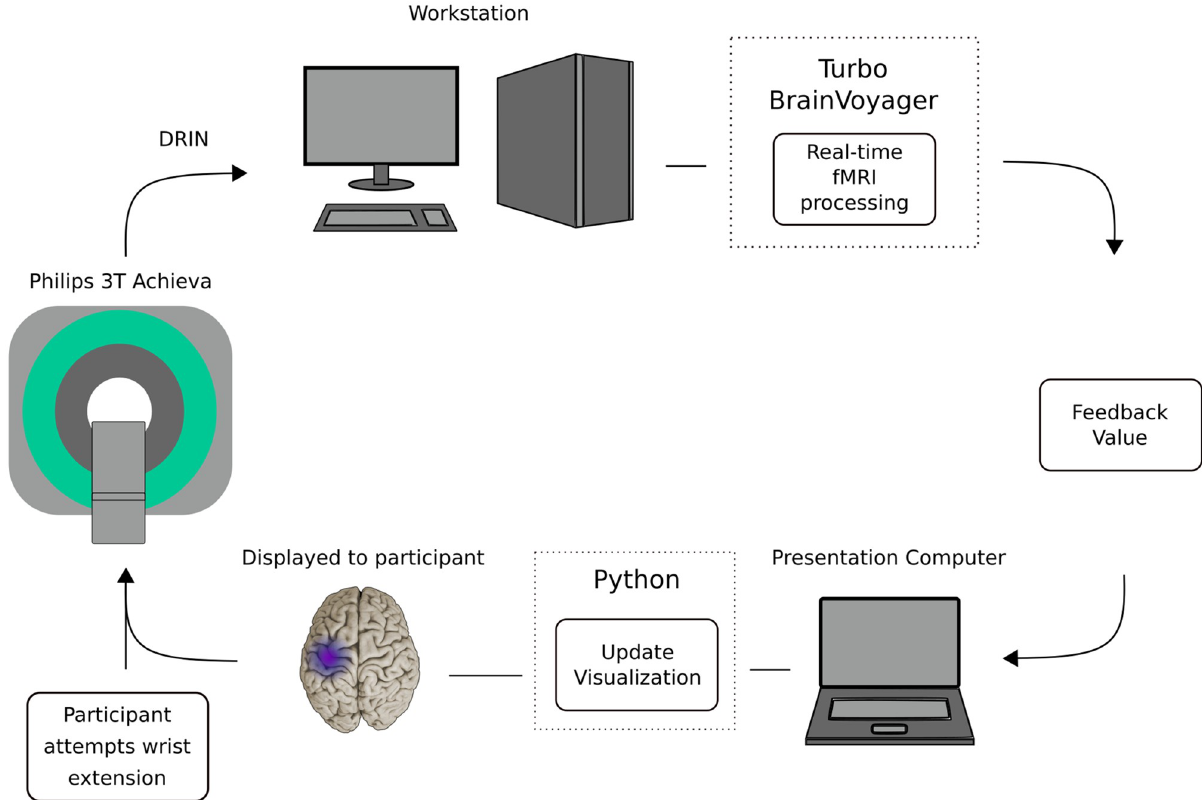
Fig 2. Real-time functional magnetic resonance imaging (fMRI) acquisition and neurofeedback system: Visual stimulation displayed by custom Python software running on a dedicated presentation computer (8-GB RAM, 2.70 GHz, Core i7 processor) running Windows 7; reconstructed image was sent via DRIN protocol (Phillips Medical Systems) to Turbo Brain Voyager software (TBV, version 3.2) running on a dedicated computer (8GB RAM, 3.6GHz, Xeon E5-1620) to identify active voxels within a defined region of interest (ROI) in real-time. The feedback estimation was performed in TBV and saved as a bitmap (.PNG file) to disk in a shared network directory. These files were picked up by custom Python software for final display to the subject. The feedback stimulus consisted of a brain picture with a purple icon superimposed. The icon changed in size and brightness to reflect the level of activation in the ROI. This visual stimulus was the source of neurofeedback. (With permission, [39]).